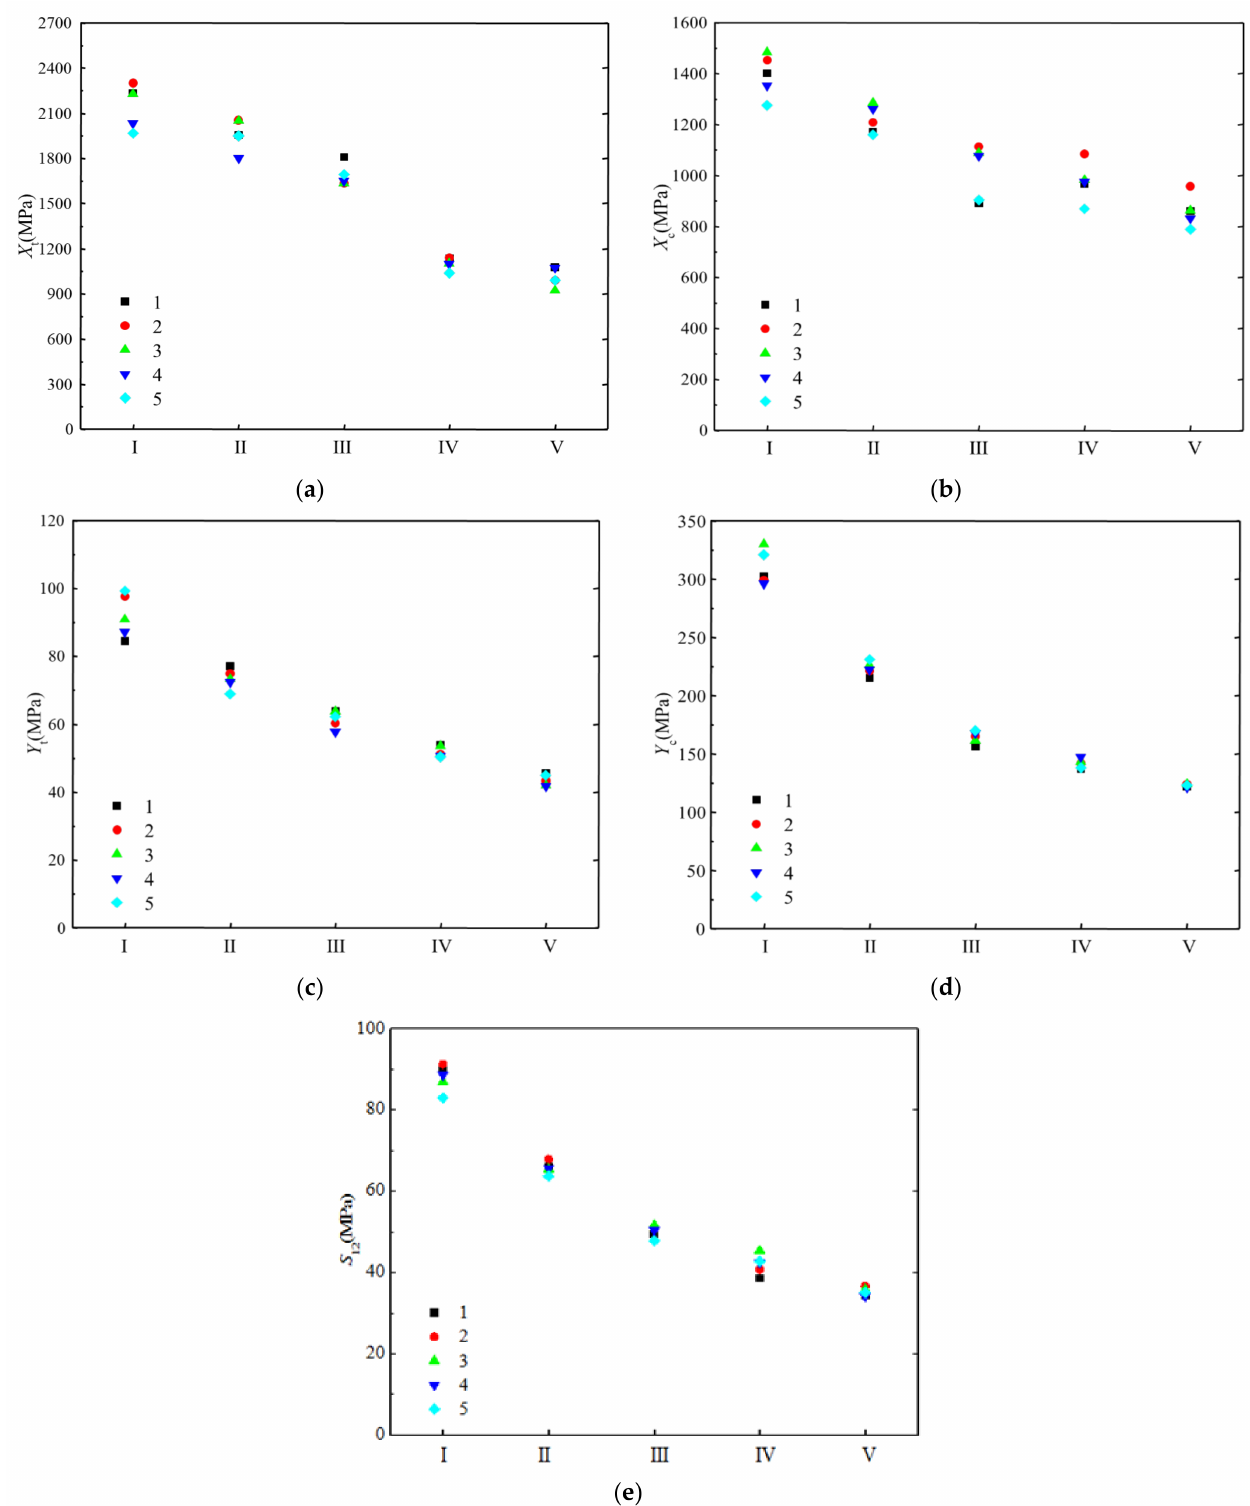
Figure 4. Test results of the strength properties of H-GFRPs. ( a ) X t , ( b ) Xc, ( c ) Y t , ( d ) Y c , ( e ) S 12